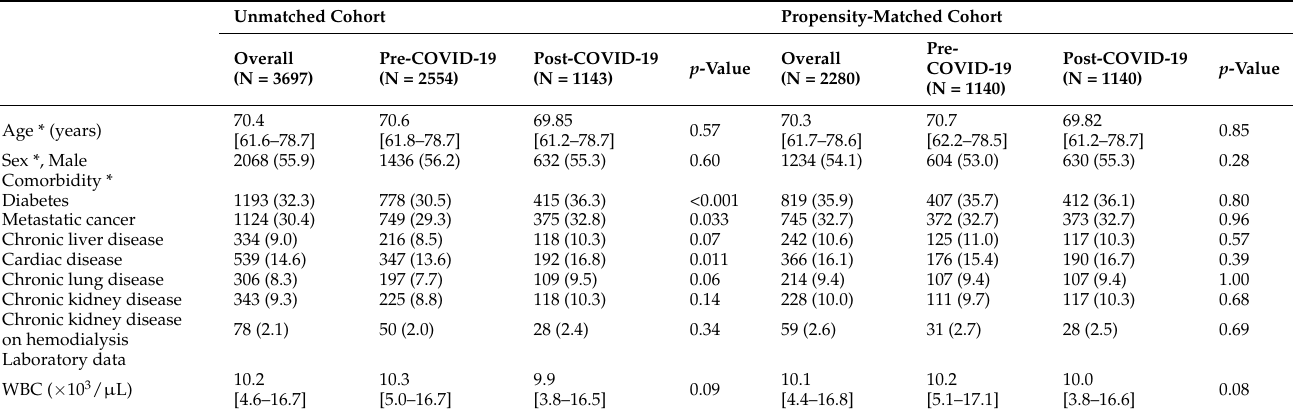
Table 1. Baseline characteristics of unmatched and propensity-matched cohorts.